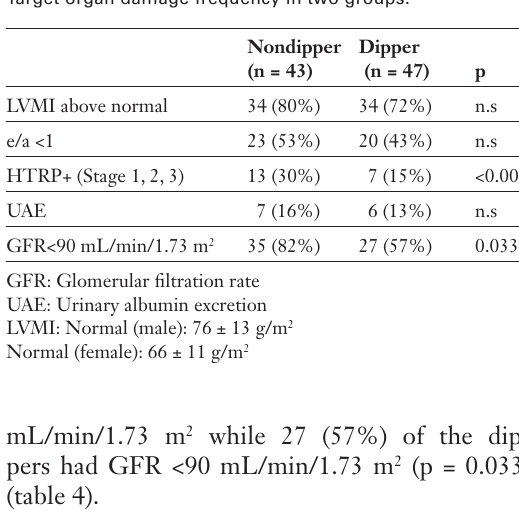
Target organ damage frequency in two groups. Carotid doppler ultrasound